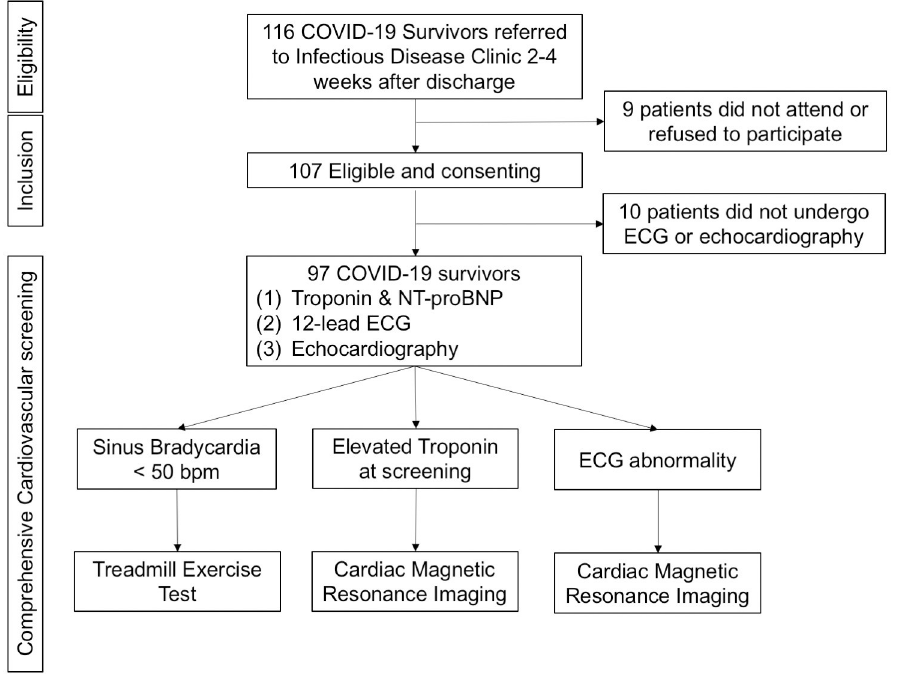
Fig 1. Study population and the screening